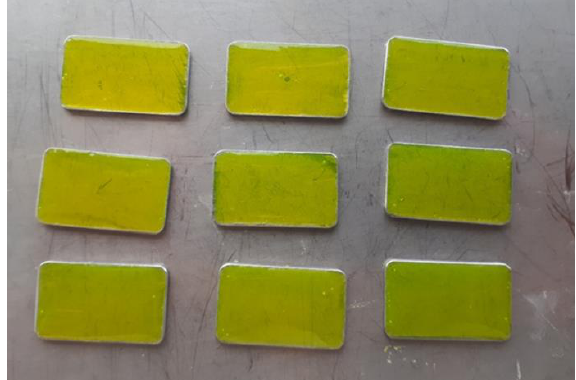
Figure 5. SSC samples with the fouling material.